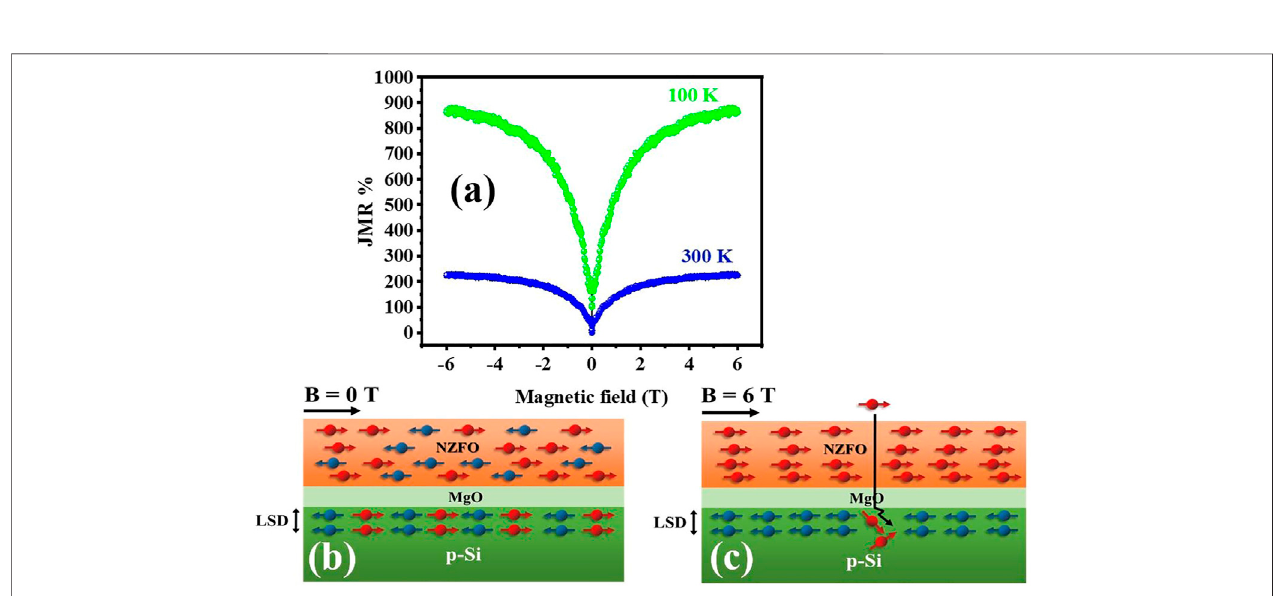
FIGURE10|(A) PercentagechangeofJMRoftheheterojunctionwiththechangeinmagnetic fi eldupto6 Tattwodifferentisothermalconditions(100and300 K). (B,C) Schematic diagrams of the suggested spin injection model of the NZFO/p-Si heterostructure which explains the source of positive JMR in our heterojunction.